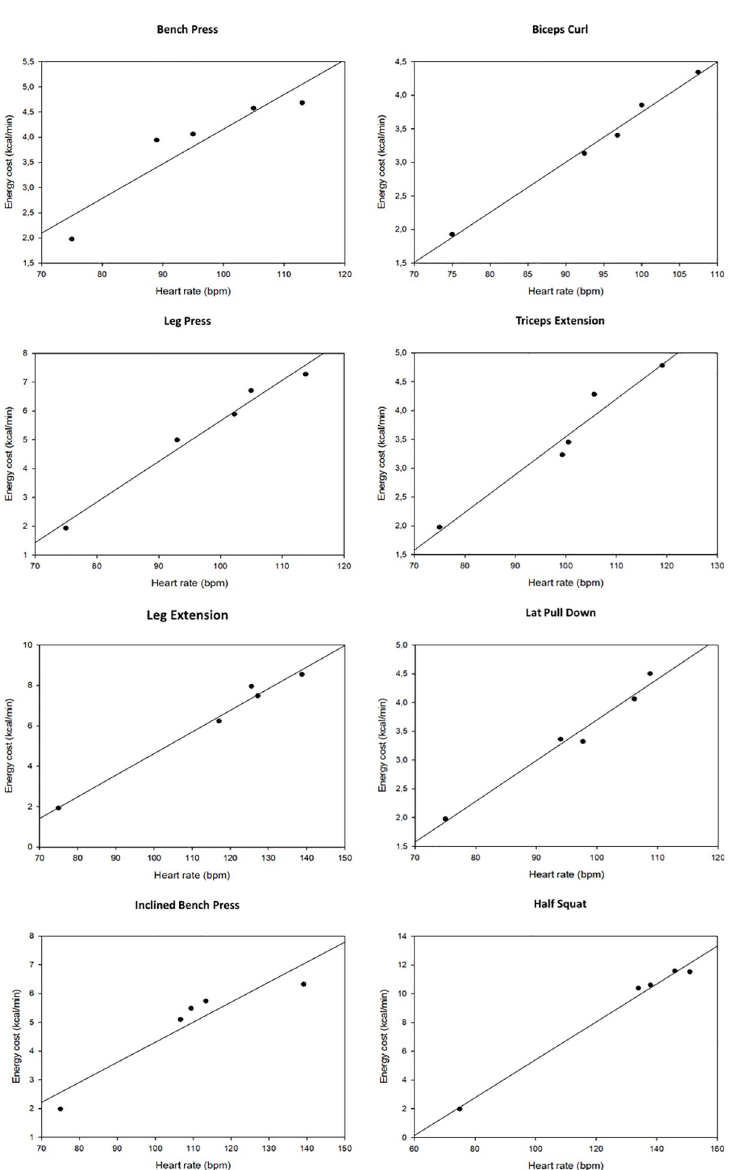
Fig 1. Simple linear regressions between heart rate and energy cost in the eight resistance